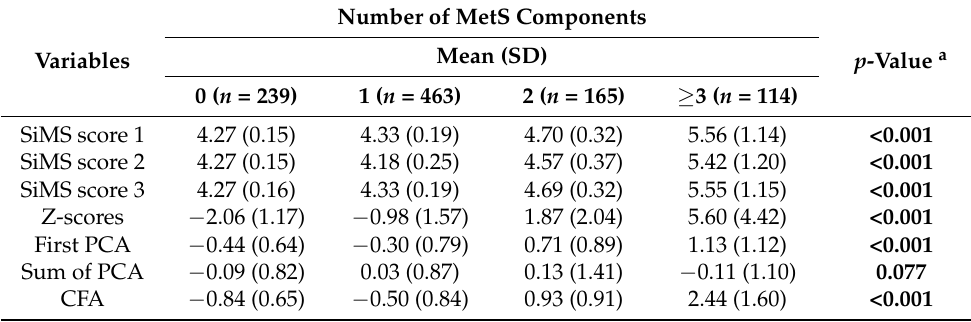
Table 2. Comparison of cMetS scores across the number of adverse risk factors.